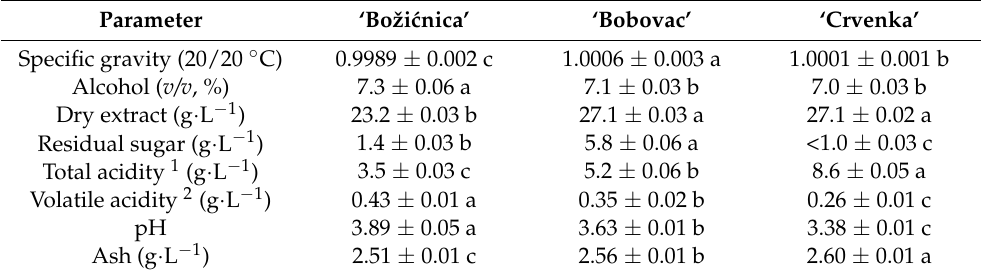
Table 2. Basic enological parameters of P é t-Nat